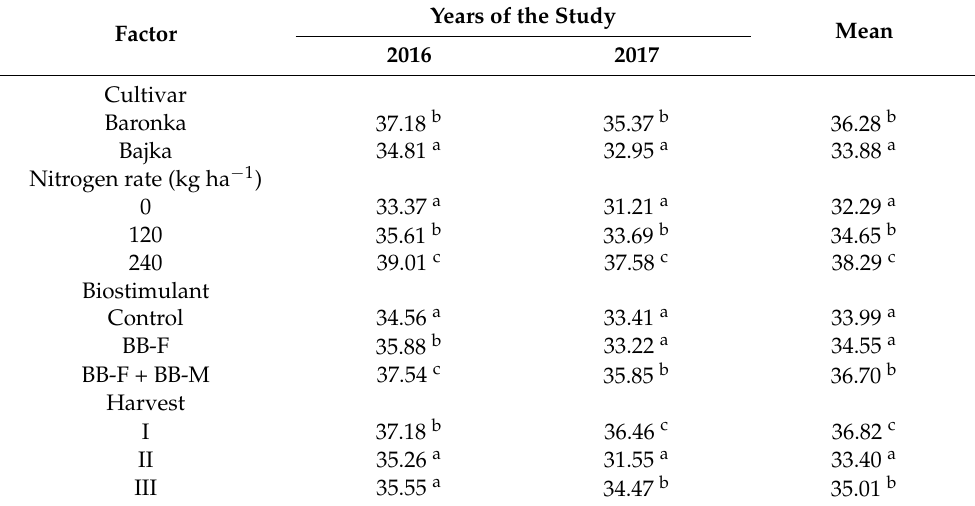
Table 4. Leaf greenness index